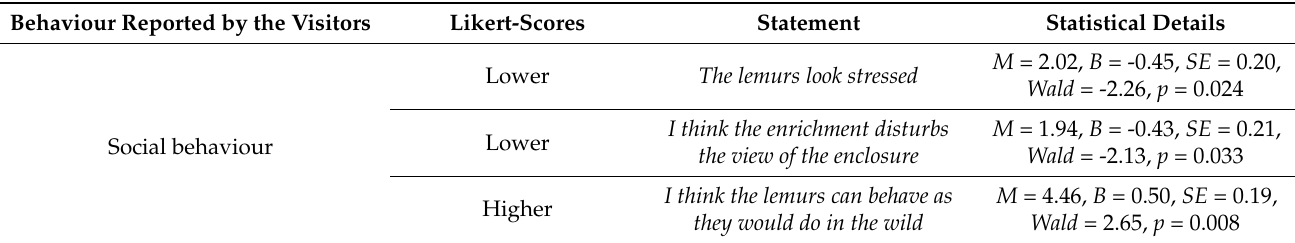
Table 6. Relationship between visitor attitudes and the lemur behaviours as perceived by the visitors (binary: yes or no). Only significant results are presented. M = mean; B = regression coefficient; SE = standard error; Wald = value of the Wald test for statistical